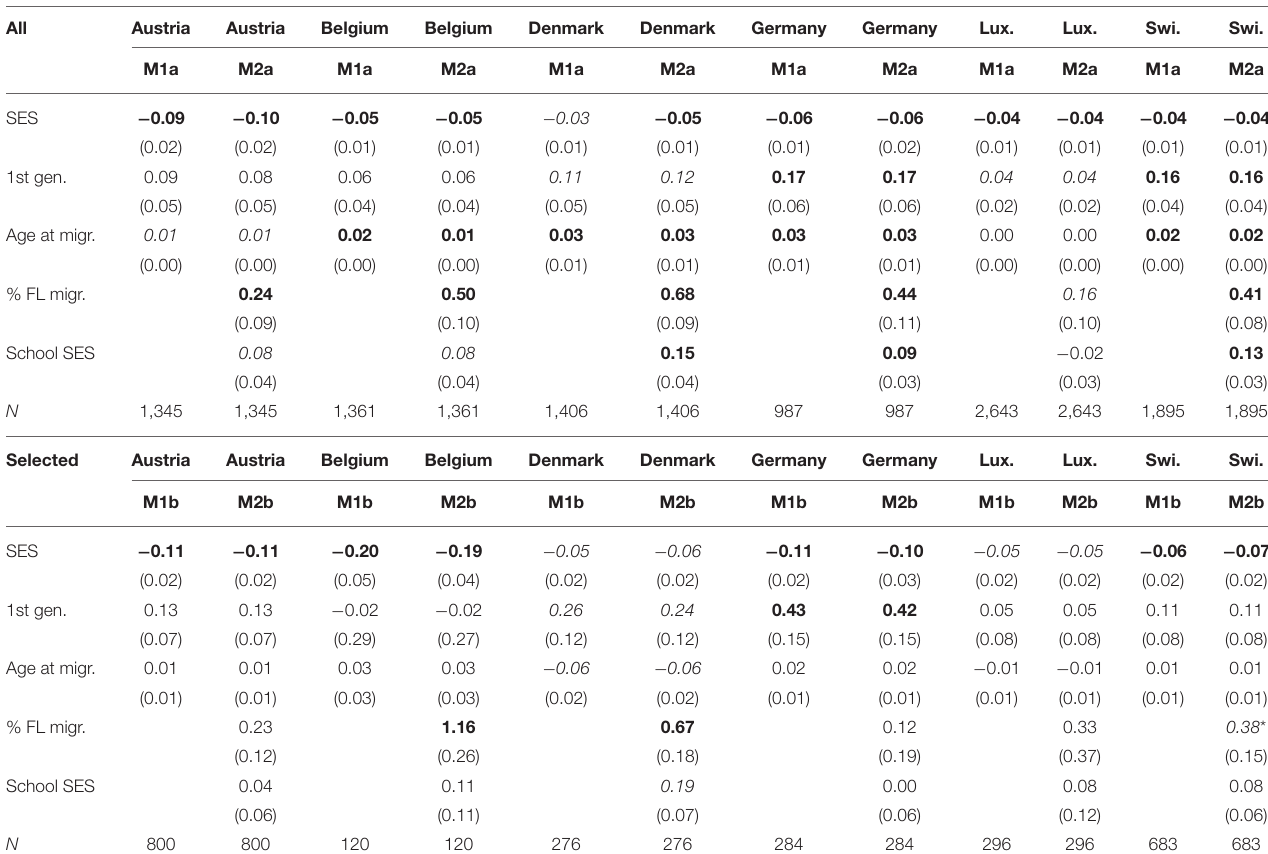
TABLE 3 | Predictors of speaking mainly the L1 with parents among all (upper panel) and selected group (lower panel).